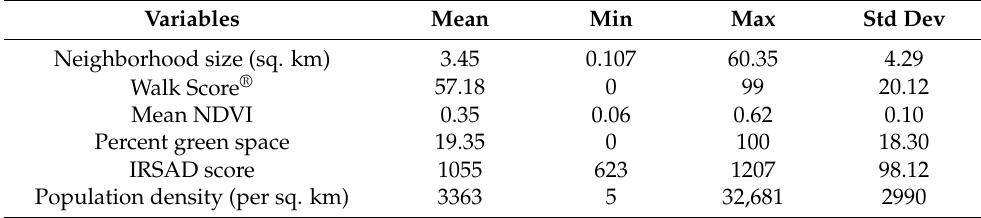
Table 1. Summary statistics.